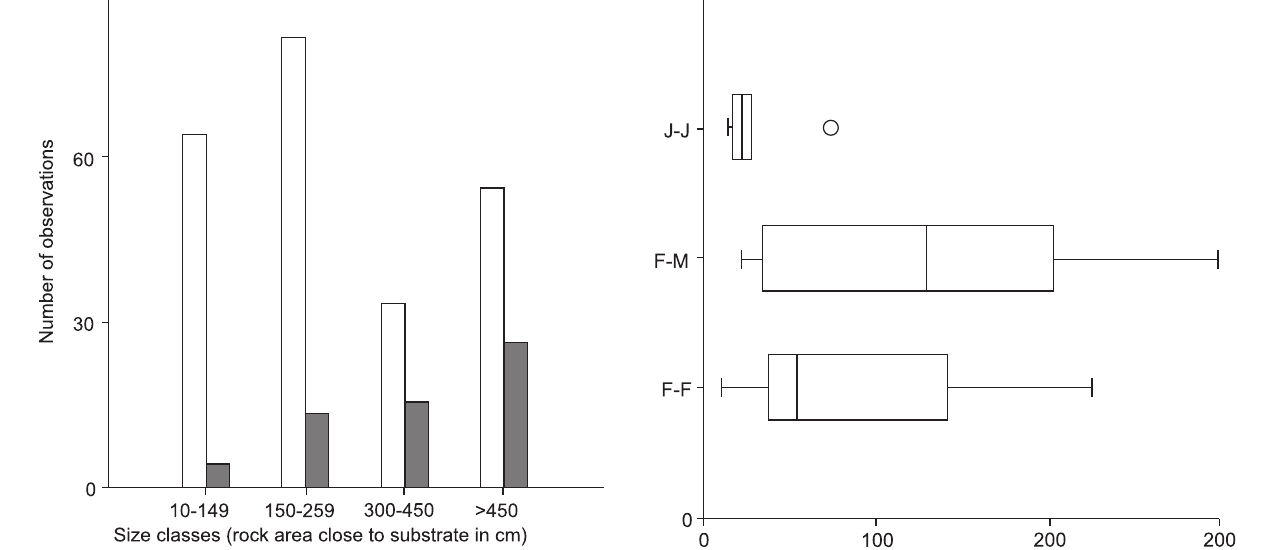
Figure 1. Number of rocks observed without (white bars) and with (black bars) individuals of Charinus asturius per classes of sizes re- garding the area (cm) close to the substrate. For the sake of clarity the size classes were divided 150cm 2 ranges, except for the class (above 450cm 2 ) in which the median was 670.4 cm 2 and the values range from (459.2-2882.5 cm 2 ).